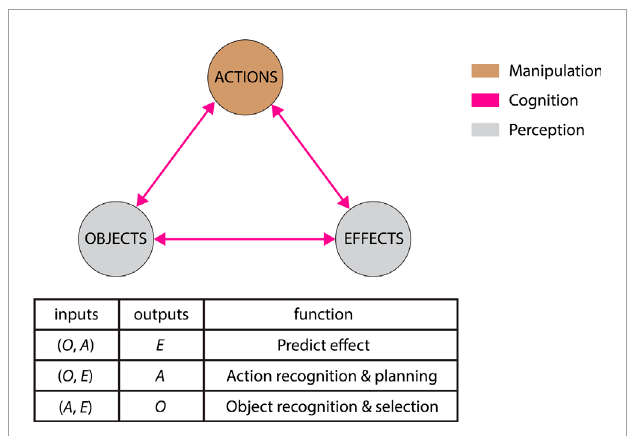
FIGURE 3 The modified affordance model in Montesano et al. (2008) © 2008, IEEE (reuse licence #5360371164789). Affordances as relations between (A)ctions, (O)bjects, and (E)ffects that can be used to address different purposes: predict the outcome of an action, plan actions to achieve a goal, or recognize objects or actions. We update the colors of the model and represent manipulation skills with brown, cognition skills with pink, and perception skills with